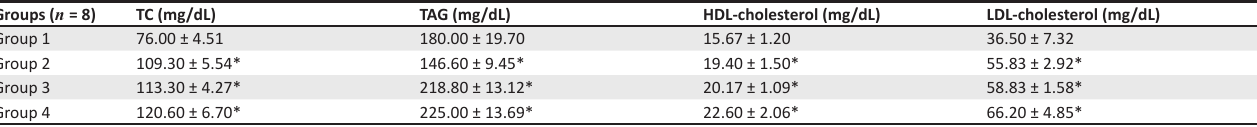
TABLE 2: Effect of calcium hypochlorite on serum lipid profiles. Groups ( n = 8)